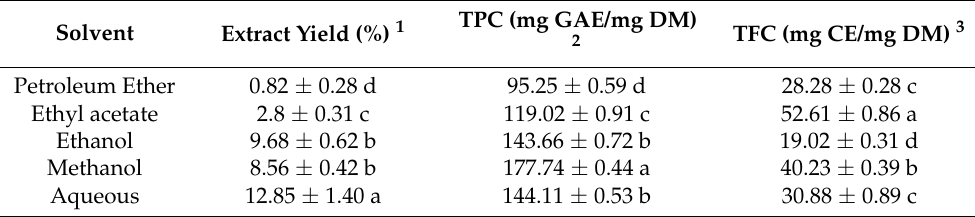
Table 5. Effects of extracting solvent on extract yield, total phenolic and flavonoid contents ( n = 3 samples, 3 replicates per sample).